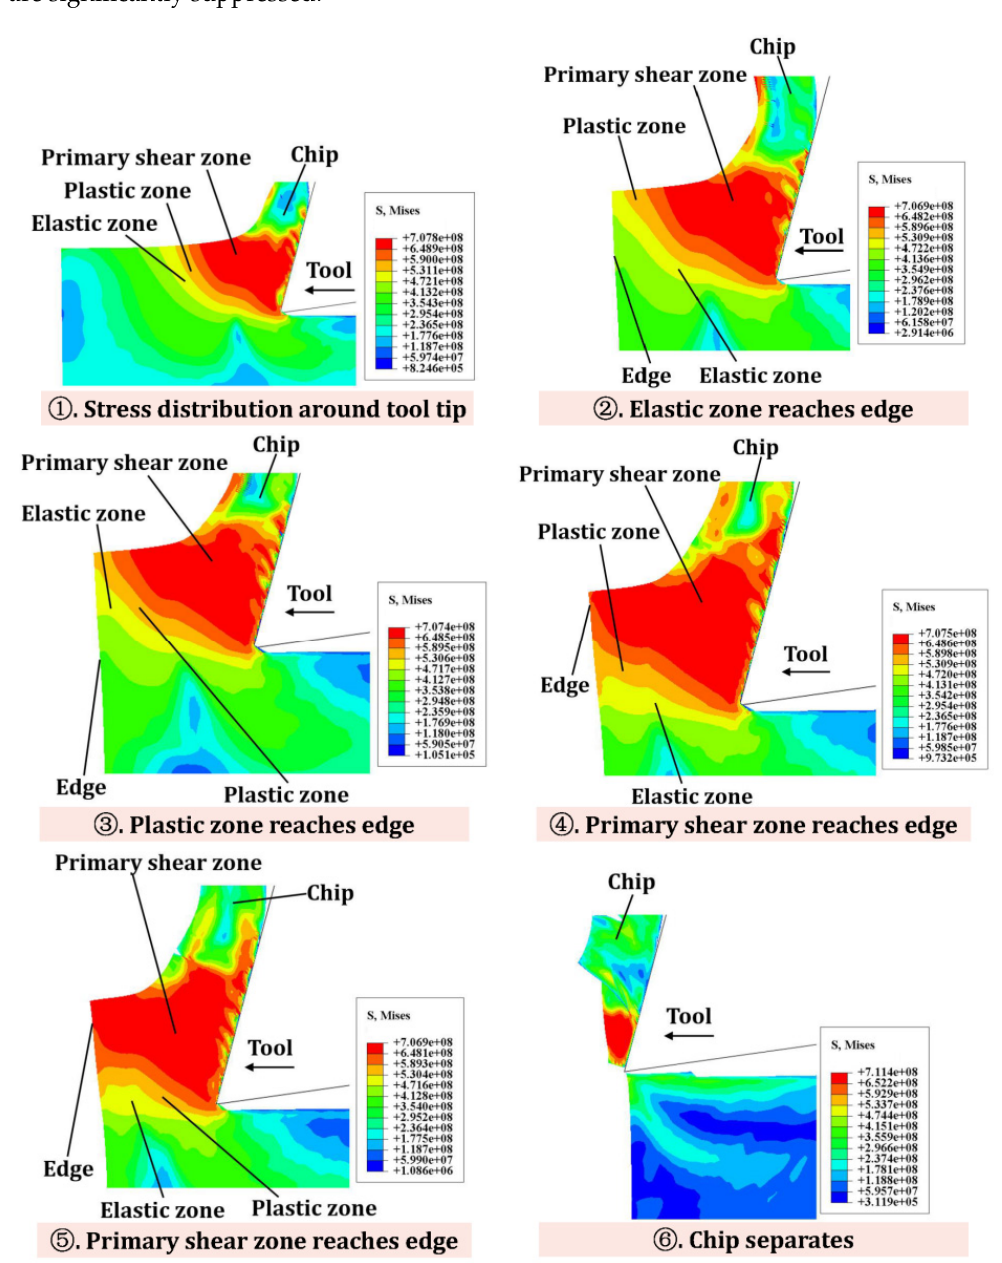
Figure 6. Schematic diagram of stress flow at workpiece edge under IBC.